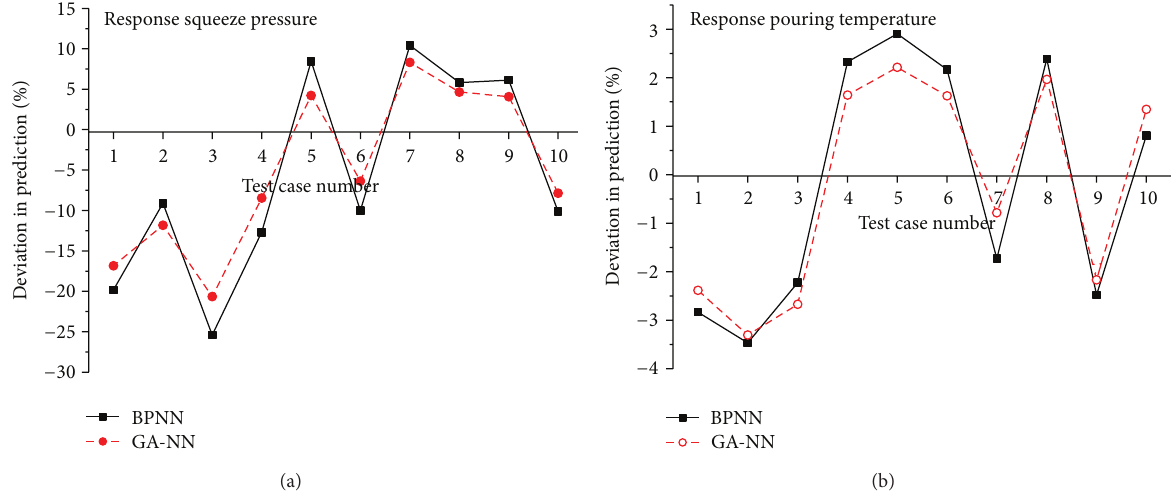
Figure 7: Comparison of NN based approaches in predicting the responses. (a) Squeeze pressure and (b) pouring temperature.